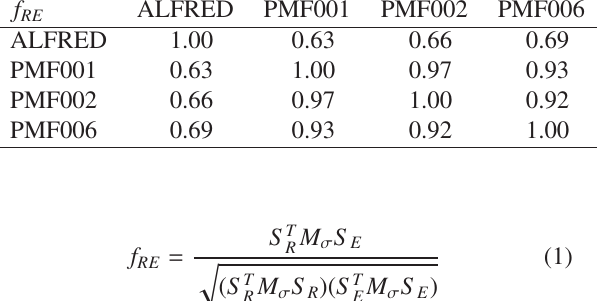
Table 8. k ef f uncertainty quantification for ALFRED with posterior JENDL-4.0u2 obtained with the DA of